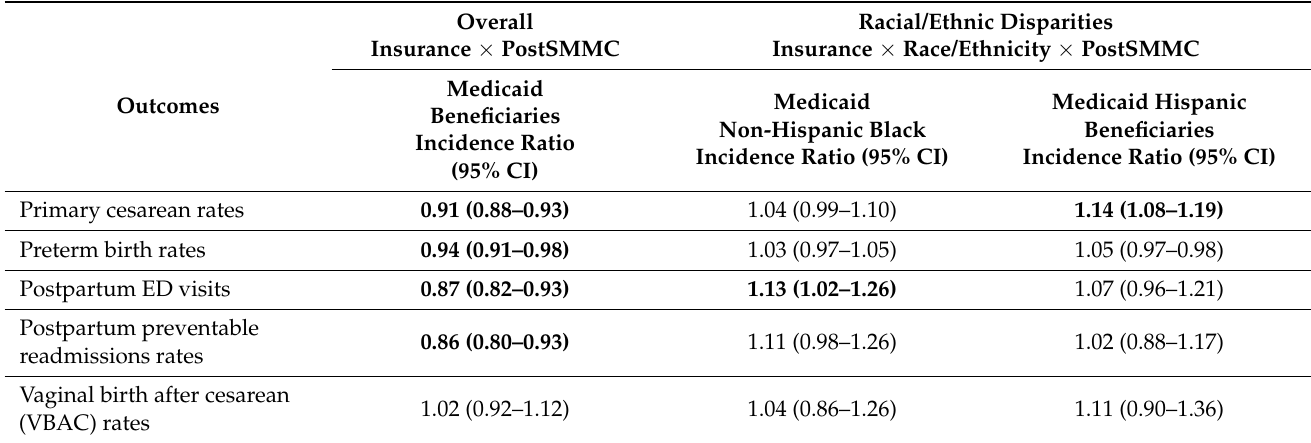
Table 2. Difference-and-difference (DID) effect estimations on obstetric hospital